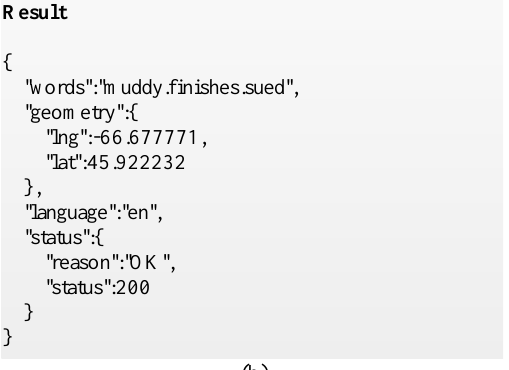
Figure 3. (a) Result of w3w forward geocoding API request